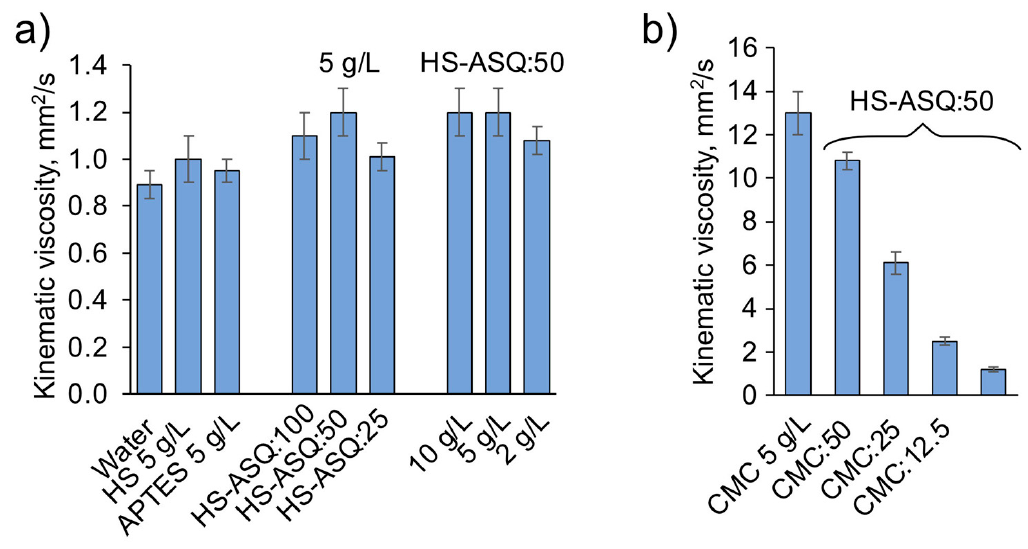
Figure 5. Kinematic viscosity of HS–ASQ compositions and control solutions after 24 h delay (25 °C) without CMC ( a ) and with CMC addition ( b ).